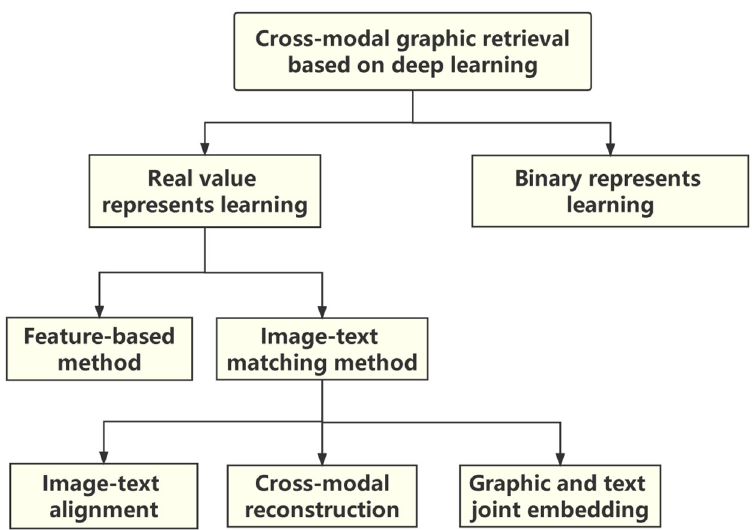
Figure 1. The classification diagram of the current research status of cross-modal graphic retrieval based on deep learning. Cross-modal graphic retrieval based on deep learning includes real valued- representation learning and binary representation learning. Real valued-representation learning is divided into two areas: the feature-based method and the image–text matching method. The image– text matching method includes image–text alignment, cross-modal reconstruction, and graphic and text joint embedding.